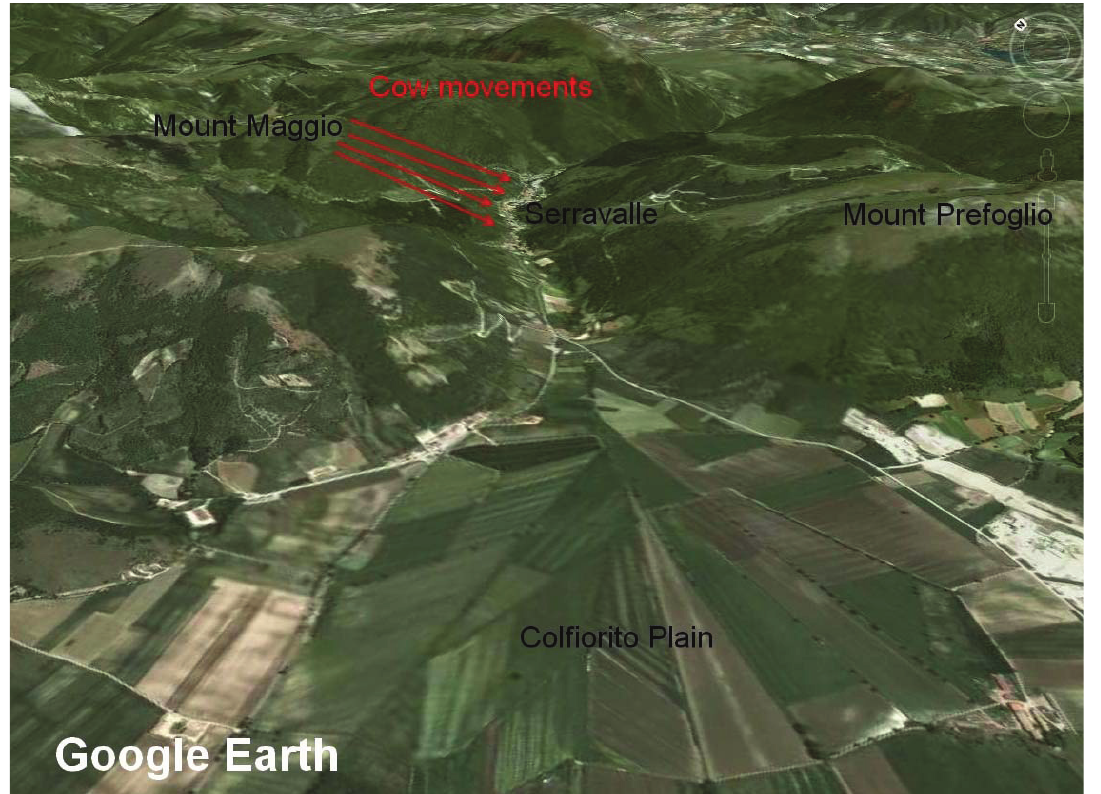
Figure 2. A Google Earth map of the Colfiorito Basin, red arrow indicates cow